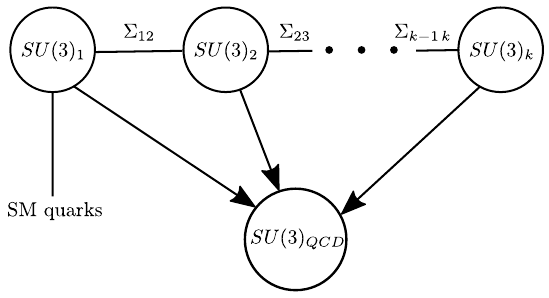
Figure 2 . Illustration of the product gauge group model introduced in [12] to enhance small instanton contributions to the axion mass. The k SU(3) factors are broken at a scale M by scalar link (cid:12)elds (cid:6) ii +1 in the bifundamental representation of SU(3) i (cid:2) SU(3) i +1 to their diagonal combination which is identi(cid:12)ed with SU(3) QCD . We further assume that the SM quarks are only charged under SU(3) 1